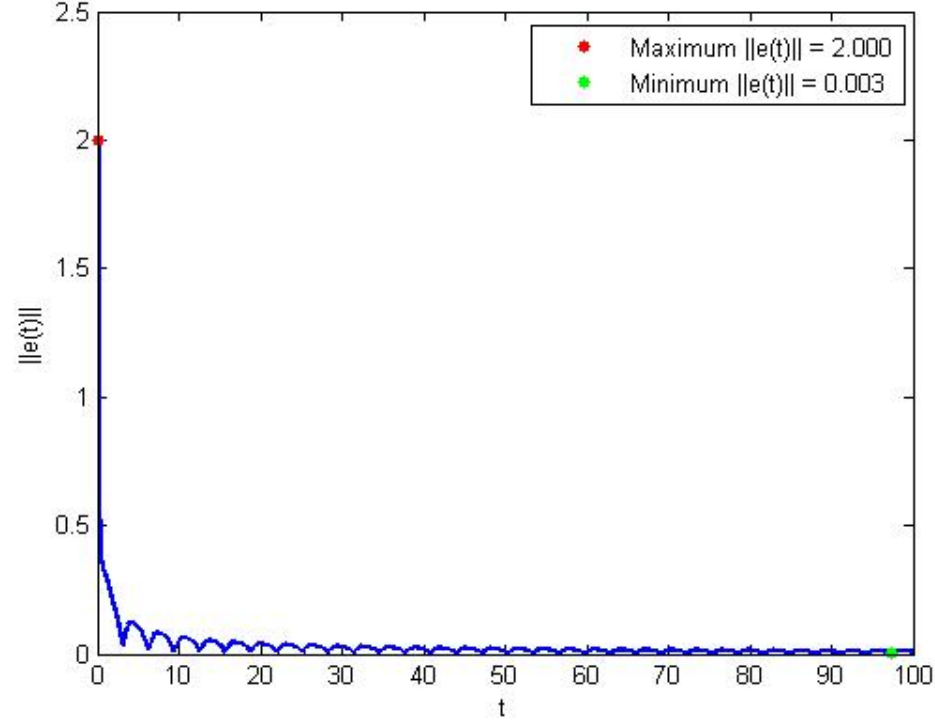
Figure 12. ‖𝜑(𝑡)‖ for system (10), with 𝛼 = 0.5 , 𝜌 = 0.5, and 𝑤(𝑡) = [1 𝑒 −𝑡 ] 𝑇 .